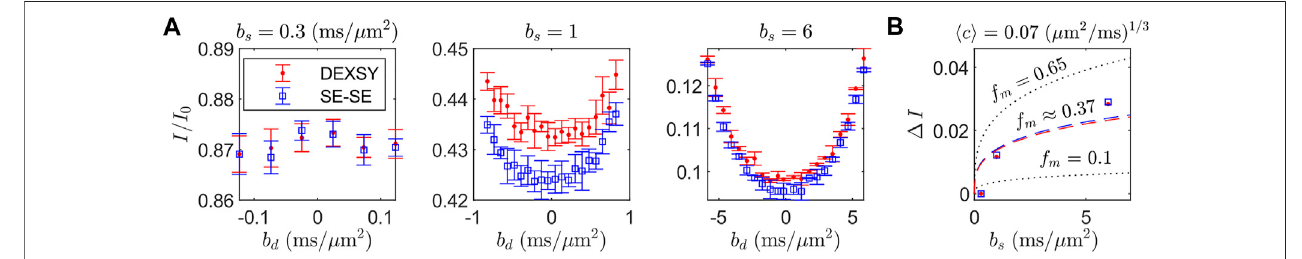
FIGURE5| Exemplarcurvatureshapeanddepth Δ I for t m atornear0measured atvarious b s onafreshlydissected,viable exvivo neonatalmousespinalcord. (A) Normalized signal I / I 0 for the SG-DEXSY with t m = 0.2 ms and SG-double spin echo (SE-SE) sequences, where I 0 was acquired at b = 0.089 ms/ μ m 2 . I / I 0 is plotted as a function of b d for three b s =(0.3, 1, 6) ms/ μ m 2 . Δ I increaseswith b s , aspredicted. Error bars = ±1 SD from three technical replicates. (B) Δ I vs. b s from (A) , where Δ I was measured as the difference between the average of the endpoints and the minimum I / I 0 point. Exemplar curves (dotted lines) are shown for f m = (0.1, 0.65) and 〈 c 〉 (cid:1) 0 . 07 ( μ m 2 /ms ) 1/3 . NLS fi ts using this fi xed 〈 c 〉 (dashed lines) yield f ≈ 0.37 (RSS = 1.3 × 10 – 4 ). An initial guess of f m m = 0.2 was